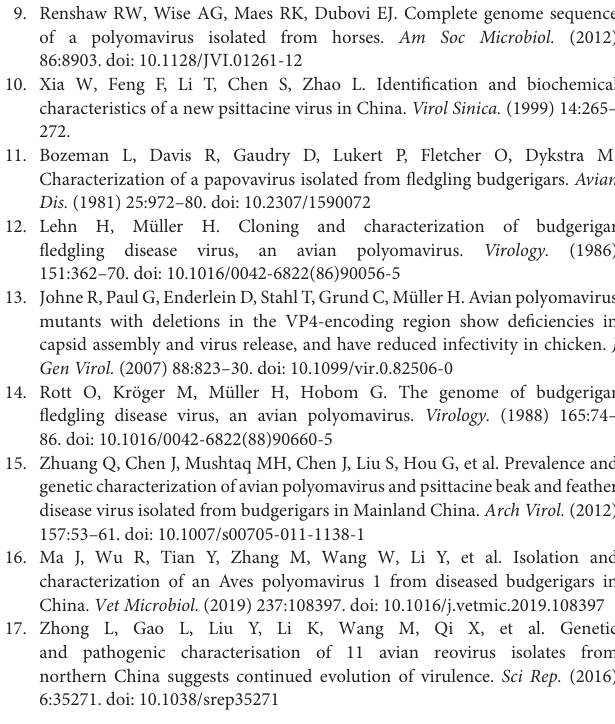
Supplementary Figure 1 | Draft enhancer element of SC-YB19 (in red box). Supplementary Figure 2 | (A) 18-nt deletion in the enhance element at nucleotide position 164–182 of the SC-YB19; (B) Result of the ABI sequencing for SC-YB19. Supplementary Figure 3 | Nucleotide sequences alignments between SC-YB19 and SD18, WF-GM01, QDJM01, AY672646, AF118150, APV-7, AF241168, AF241169, AF241170, M20775, and NC004764. Supplementary Figure 4 | Multiple sequence alignment of complete sequences in BFDV